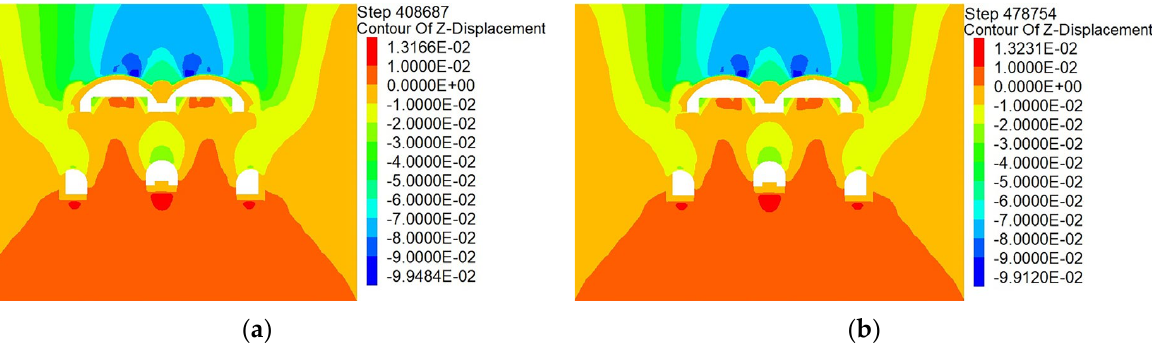
Figure 20. Vertical displacement cloud diagrams of different schemes. Arch completed in ( a ) one and ( b ) two attempts.